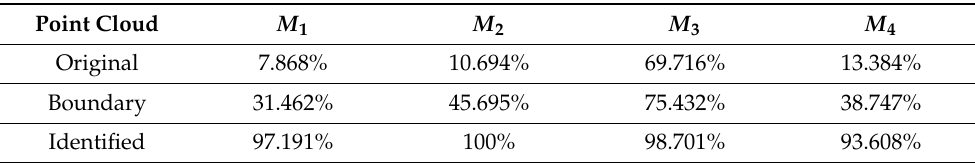
Figure 9. Comparison results of accuracy of correspondences under several conditions for different point clouds. ( a ) Comparison results under different conditions of M 1 point clouds; ( b ) M 2 ; ( c ) M 3 ; ( d ) M 4 . Table 2. Quantification result of the inlier ratio of correspondences under several conditions for different point clouds.